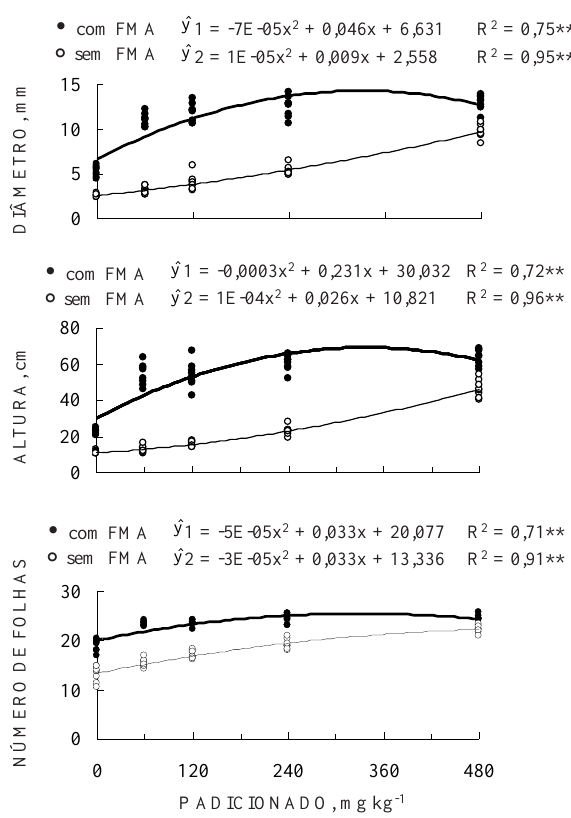
Figura 4. Diâmetro médio (aos 126 dias), altura média (aos 131 dias) e número médio de folhas (aos 131 dias de idade) de plantas de mamoeiro, com e sem inoculação com Glomus macrocarpum , considerando o fósforo adicionado ao substrato, fase de vaso. Média de oito